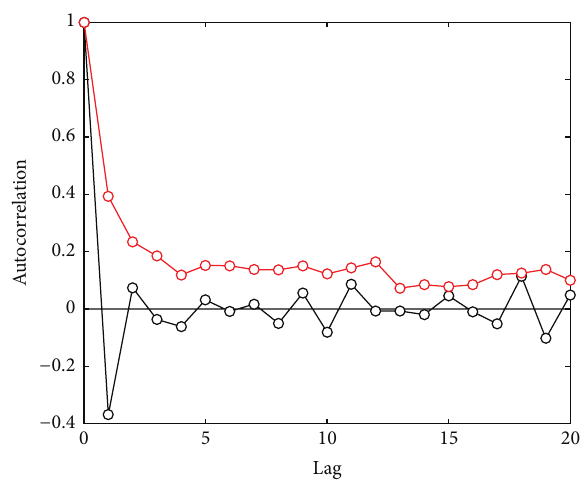
Figure 4: Autocorrelation function of the simulated stock 1. The black line shows the autocorrelation function of the returns. The red line is the autocorrelation of the absolute returns.